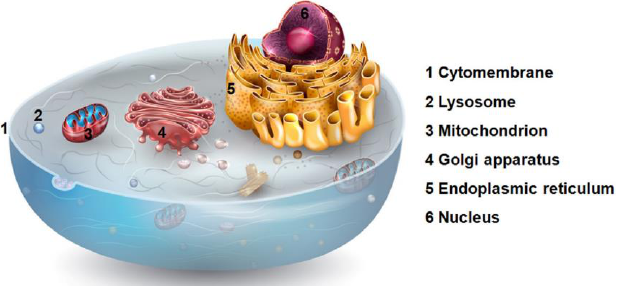
Figure 18. Representation of the most important organelles in the eukaryotic cell. (Reprinted with permission from ref. [76]. Copyright 2019 Elsevier).